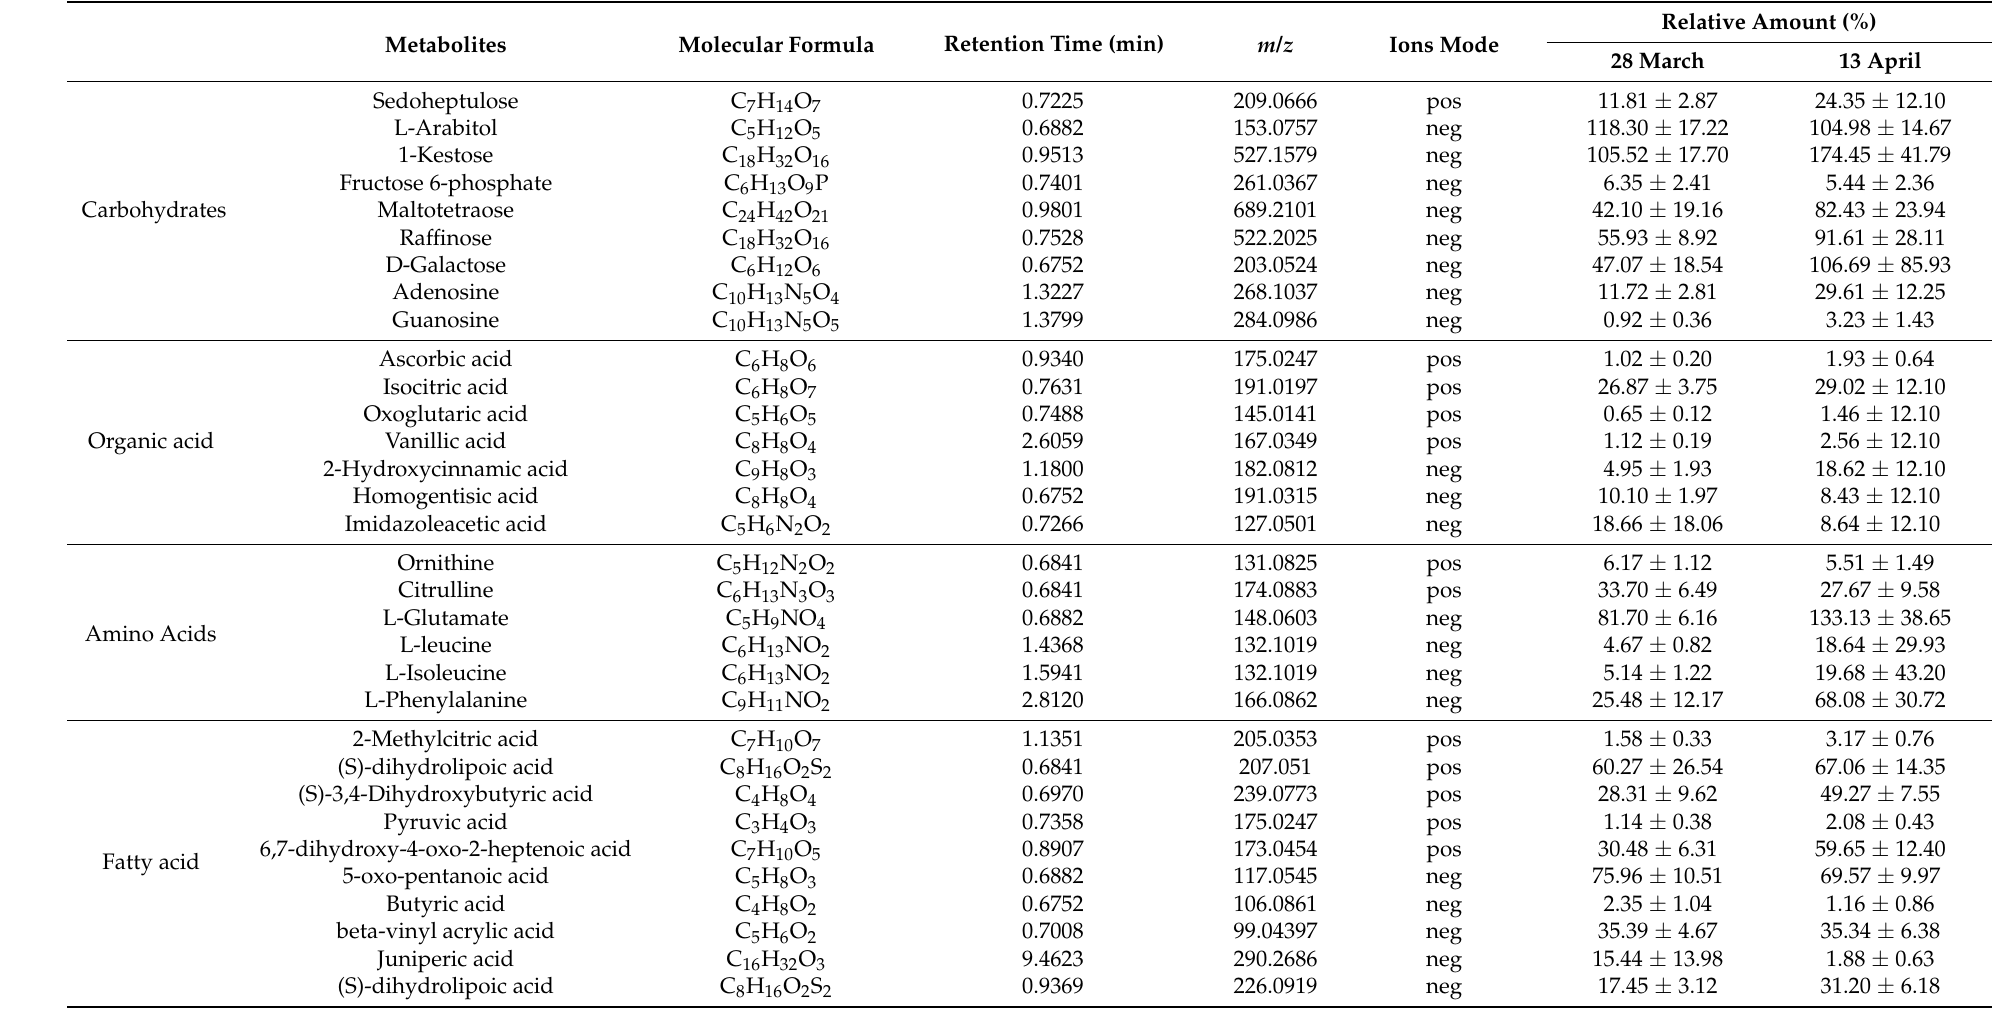
Table 2. Identified metabolites and their relative amount of metabolites in immature